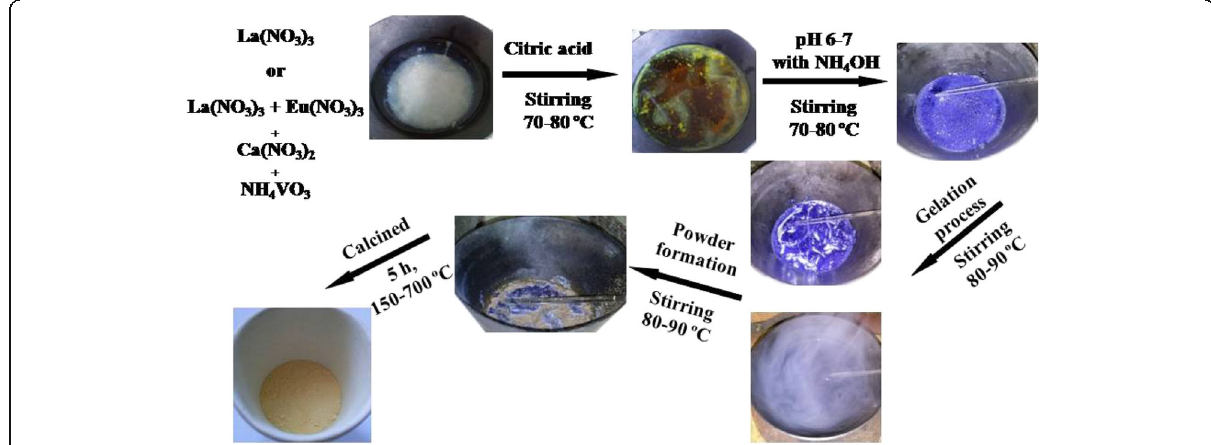
Fig. 1 Schematic diagram showing the experimental process for synthesis of the La 1 − x Ca x VO 4 and La 1 − x − y Eu y Ca x VO 4 (0 ≤ x , y ≤ 0.2)